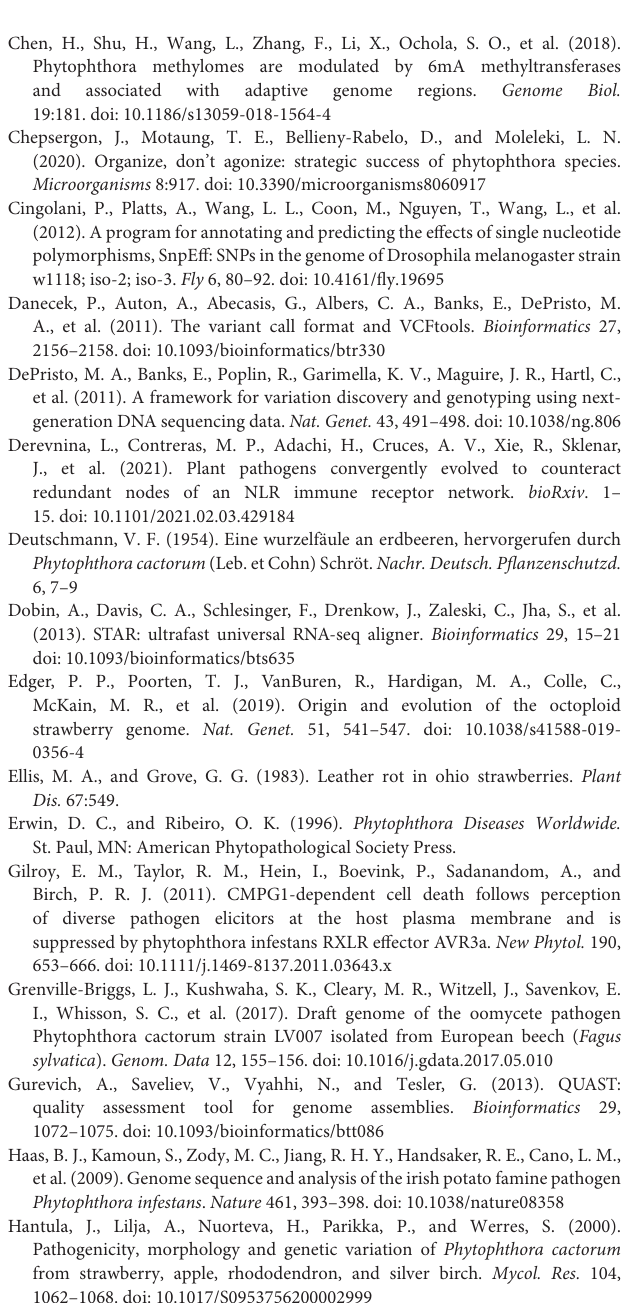
Supplementary Table 5 | Summary of homologues to known avirulence RxLR genes in Phytophthora cactorum . The region of genes for comparison are detailed in column three, noted as amino acid (AA) sequence after signal peptide